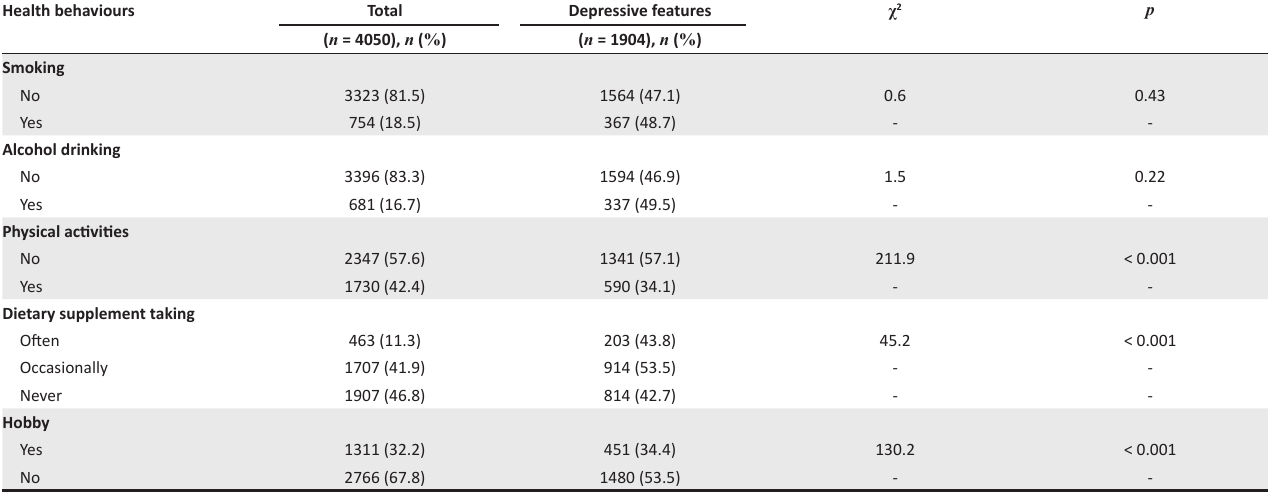
TABLE 2: Comparison of health behaviours by depressive features.